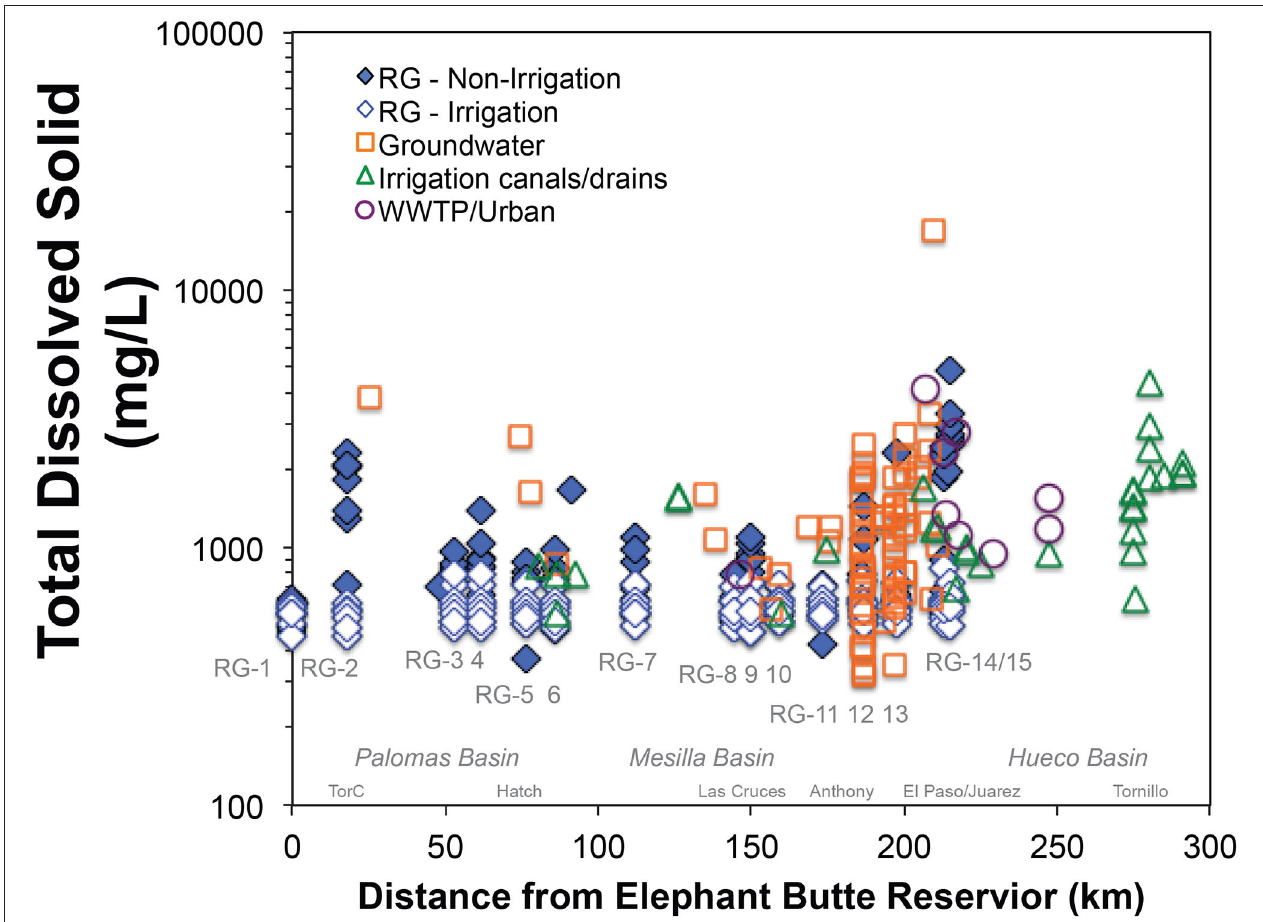
FIGURE 3 | Total dissolved solids (mg/L) in Rio Grande river water, groundwater, agricultural canals and drains, and urban water (wastewater treatment plants: WWTP). The Rio Grande river water is classified into non-irrigation and irrigation seasons. The sample locations are placed with distance (km) from Elephant Butte Reservoir along the Rio Grande. Major cities and alluvial basins are